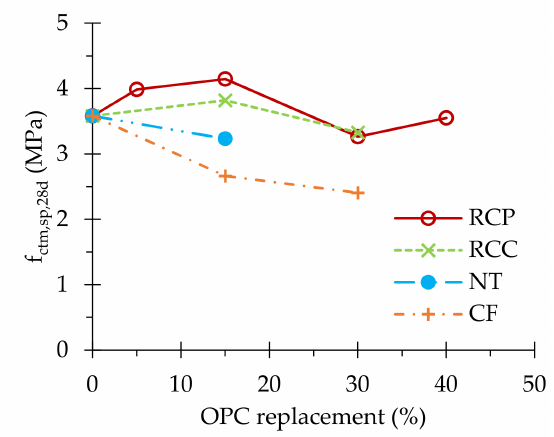
Figure 16. Tensile splitting strength at 28 days, f ctm , sp ,28 d , of concrete with w/b of 0.55 and different percentages of